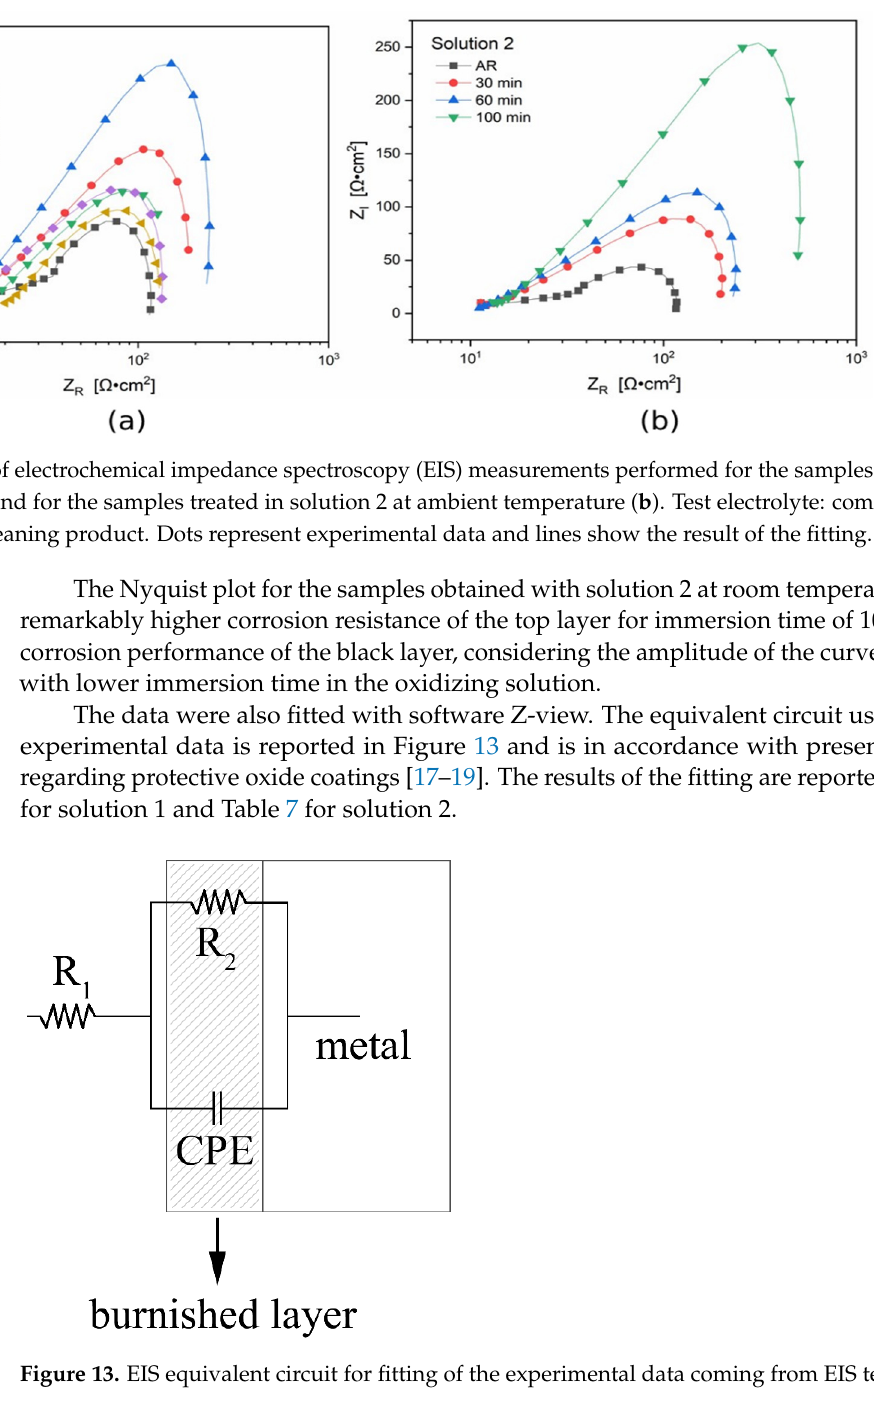
Table 6. Results of the fitting of the experimental data for the samples obtained with solution 1 at 50 °C.